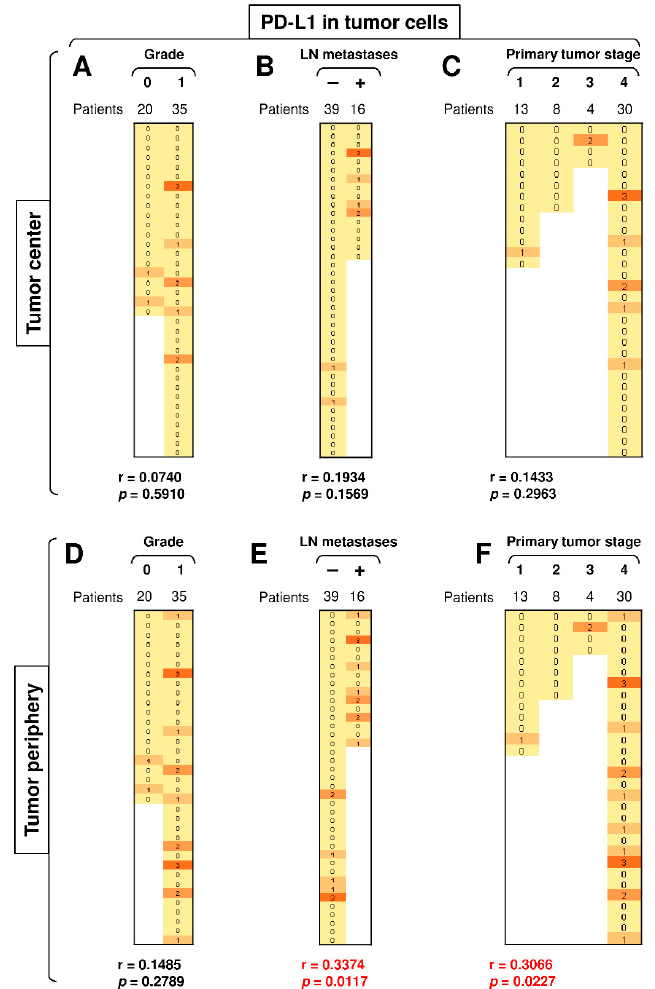
Figure 6. The presence of LN metastases and primary tumor stage significantly correlate with PD-L1 expression in peripheral tumor cells. ( A ) The cohort of 55 SGC patients was stratified into 2 groups according to tumor grade (grade 0 and grade 1), and the Spearman correlation with the expression of PD-L1 in tumor cells in the tumor center was determined. ( B ) The patient cohort in ( A ) was stratified into 2 groups according to the presence (+) or absence (–) of LN metastases, and the Spearman correlation was determined as in ( A ). ( C ) The patient cohort in ( A ) was stratified into 4 groups according to the primary tumor stage, and the Spearman correlation was determined as in ( A ). ( D – F ) The cohort of 55 SGC patients was stratified into groups as in ( A – C ), and the Spearman correlation with the expression of PD-L1 in tumor cells in the tumor periphery was determined. In ( A – F ), the correlations were evaluated by Spearman correlation tests, ( A – F ): n = 55. * p < 0.05 was considered significant. In ( A – F ), the expression analyses of PD-1 were performed according to the scoring system described in the Materials and Methods Section. The data are presented as a heat map with the scores. The color scale is presented as follows: yellow color: score 0; marigold color: score 1; ochre color: score 2; bronze color: score